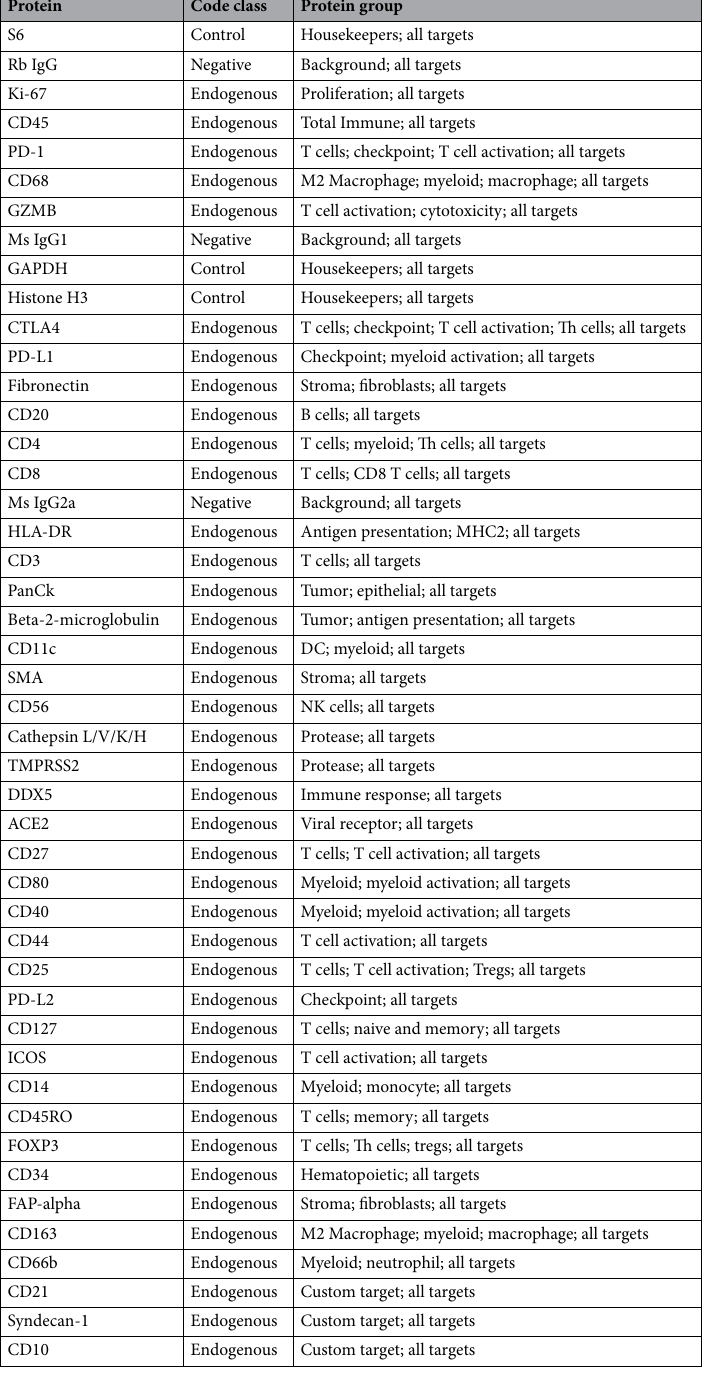
Table 2. Nanostring GeoMx protein